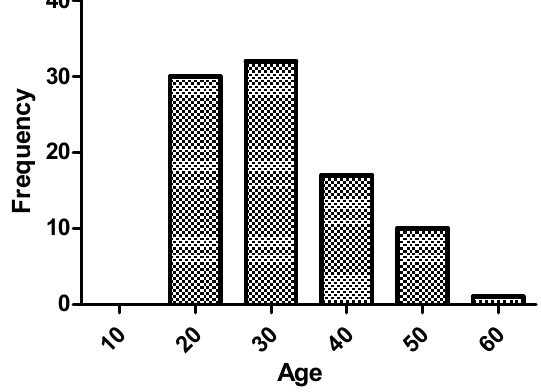
Nutrients 2022 , 14 , x FOR PEER REVIEW Figure 1. Histogram of frequency by age. Figure 1. Histogram of frequency by age.